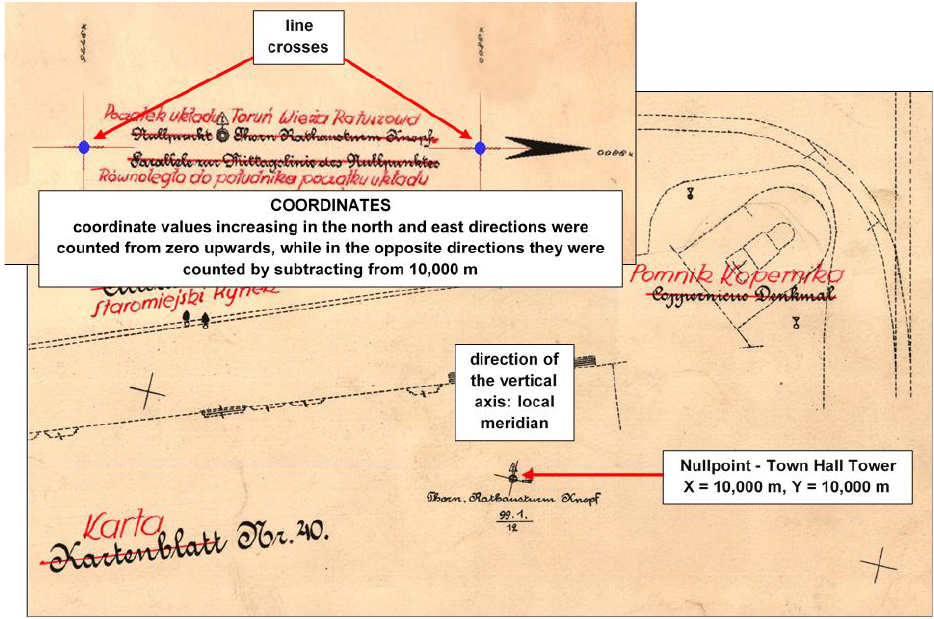
Figure 3. Local rectangular system —Toruń Town Hall Tower (Thorn Rathausturm Knopf) with the starting point (Nullpunkt). Source: Gemarkungskarte der Stadt Thorn, Blatt 40, State Archives in Toruń.